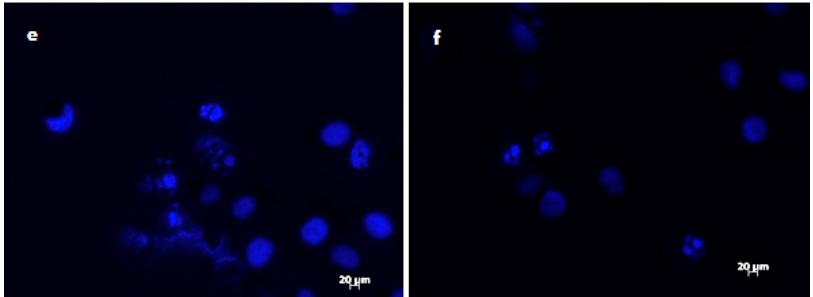
Figure 3. Morphological changes in HeLa cells treated with onion extracts examined by DAPI staining. Control (untreated cells) ( a , b ), HeLa cells treated with A. cornutum extract (IC 50 = 24.15 µg/mL) ( c , d ), and HeLa cells treated with A. cepa L. extract (IC 50 = 24.79 µg/mL) ( e , f ).